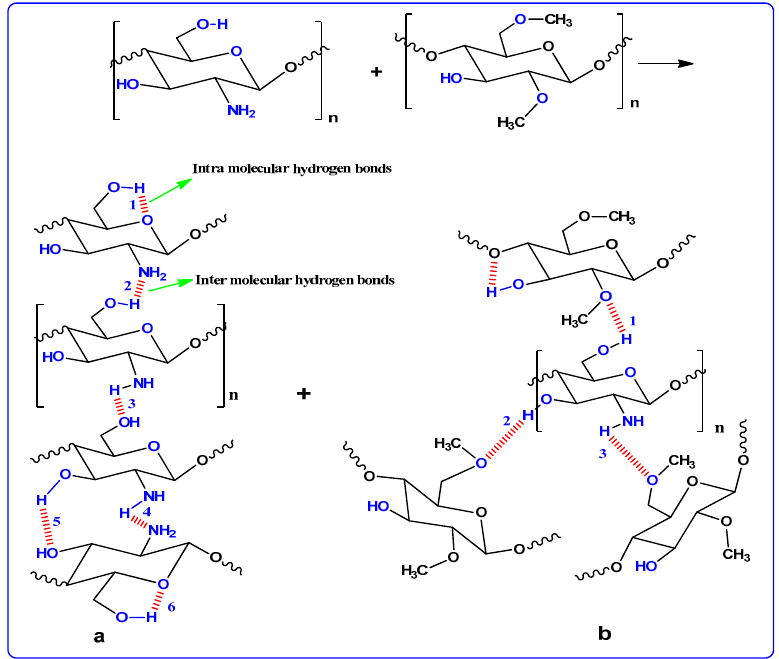
Figure 3. CS and MC polymer hydrogen bonding presentation; ( a ) hydrogen bonding through CS polymer and ( b ) hydrogen bonding CS:MC polymer blends.